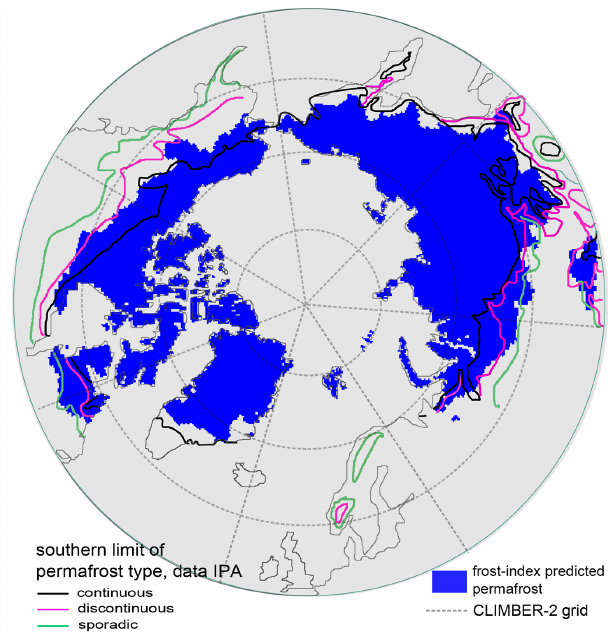
Figure 9. Map of land with frost index greater than 0.57 (frost in- dex predicted permafrost) shown in blue with southern limit of per- mafrost boundaries for the present day defined by IPA overlaid. Black line: continuous permafrost, pink line: discontinuous per- mafrost, green line: sporadic permafrost. Grey dotted lines are the CLIMBER-2 grid.